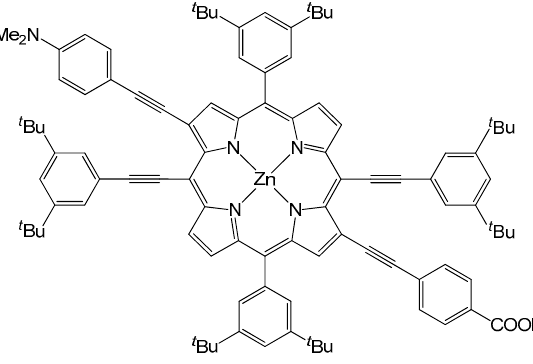
Figure 7. 2,12 β -pyrrolic tetra-arylzinc(II) porphyrin 34 .